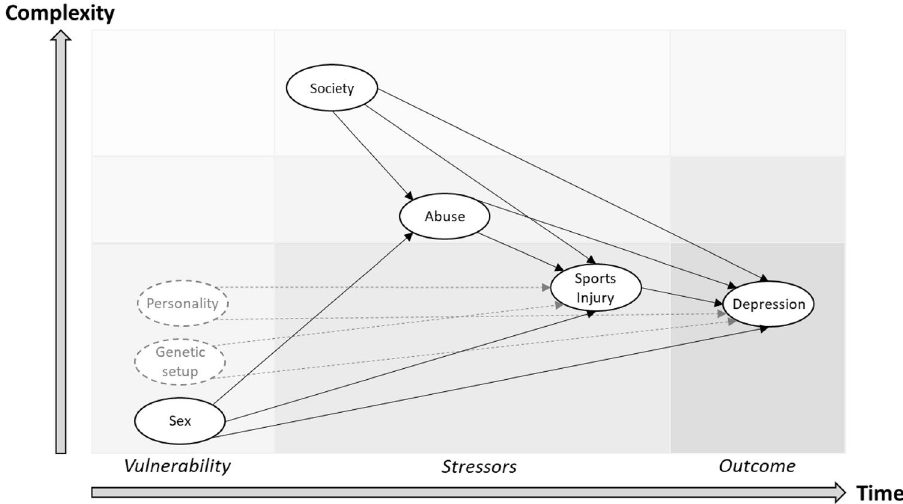
Figure 3. Diathesis-stress model of pathways from structural vulnerability and stressors to depression in young sportspersons (adapted from Ref. 23